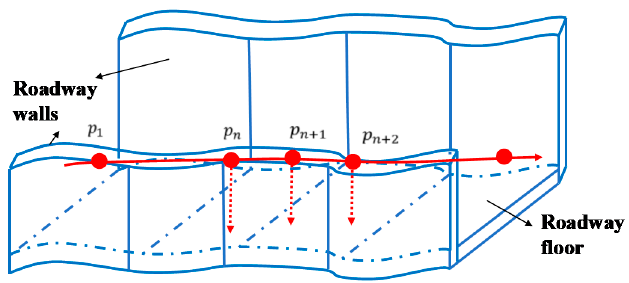
Figure 5. Schematic diagram of roadway plane constraint.